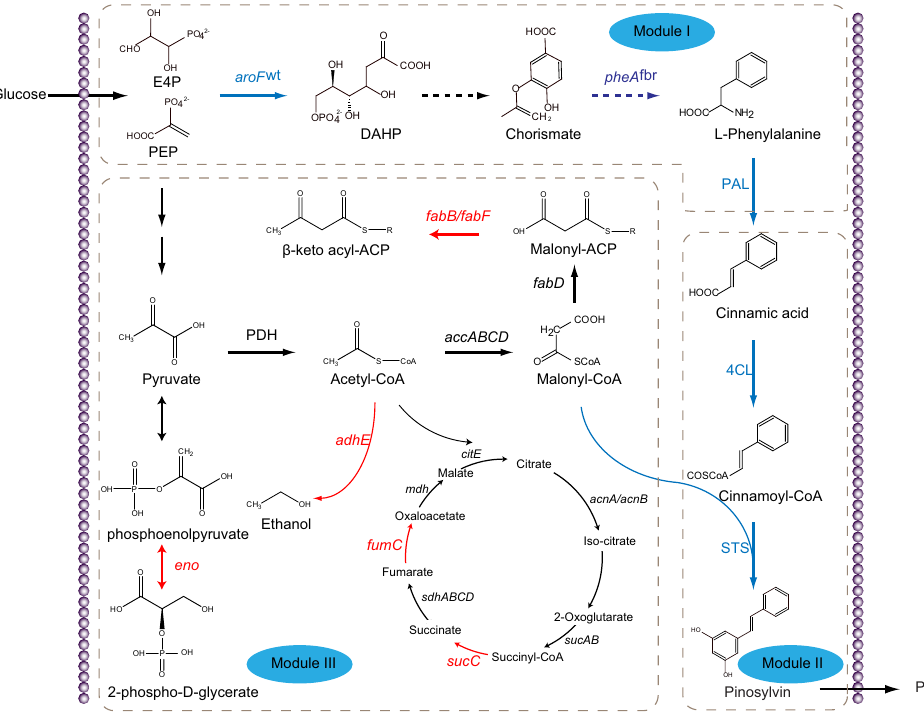
Figure 1. Schematics of the three modules. Module one consisted of aroF wt , pheA fbr and TcPAL; Module two consisted of 4CL and STS; Module three consisted of CRISPRi to redirect endogenous central metabolism. The repressing genes are shown in red. The overexpressing genes are shown in blue. E4P meant erythrose-4- phosphate; PEP meant phosphoenolpyruvate; aroF meant the gene encoding 3-deoxy-D-arabinoheptulosonate- 7-phosphate (DAHP) synthase; pheA fbr meant the gene encoding feedback-inhibition-resistant (fbr) chorismate mutase/prephenate dehydratase (CM/PDT); PAL meant phenylalanine ammonia lyase; 4CL meant 4-coumarate:CoA ligase; STS meant stilbene